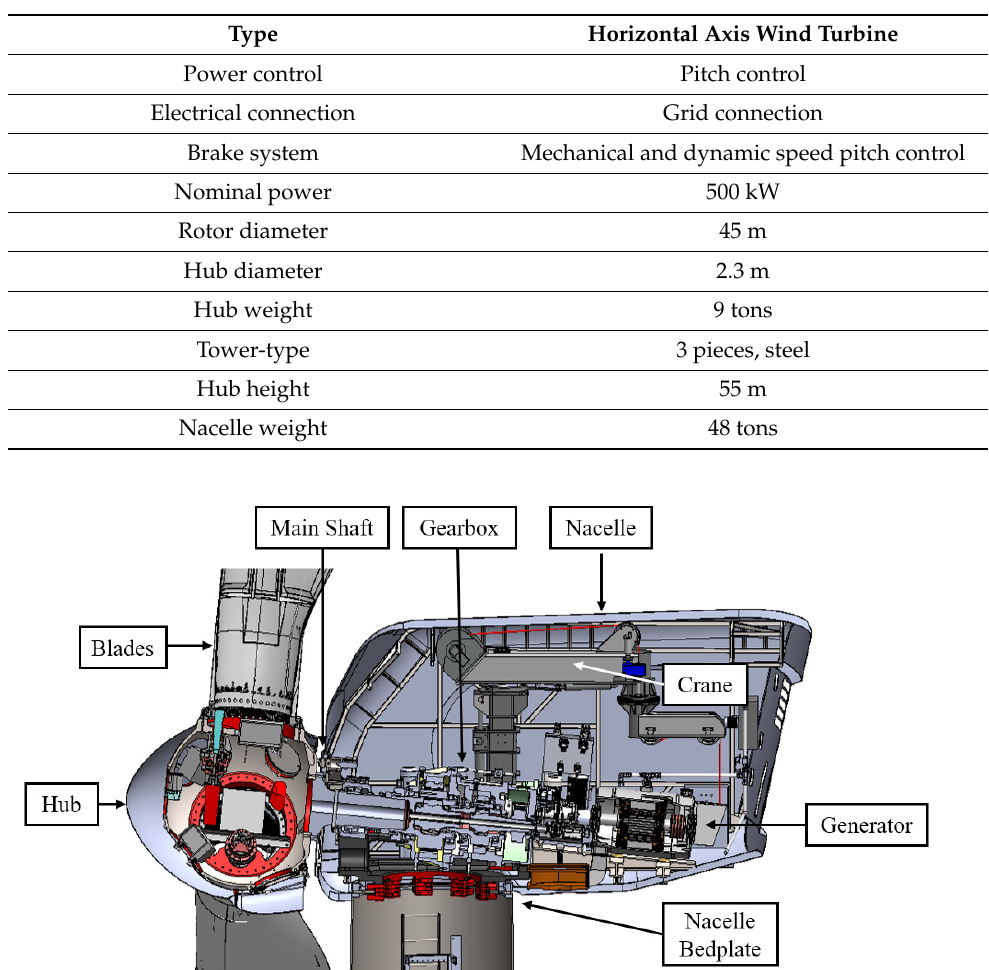
Table 5. Technical properties of the wind turbine.